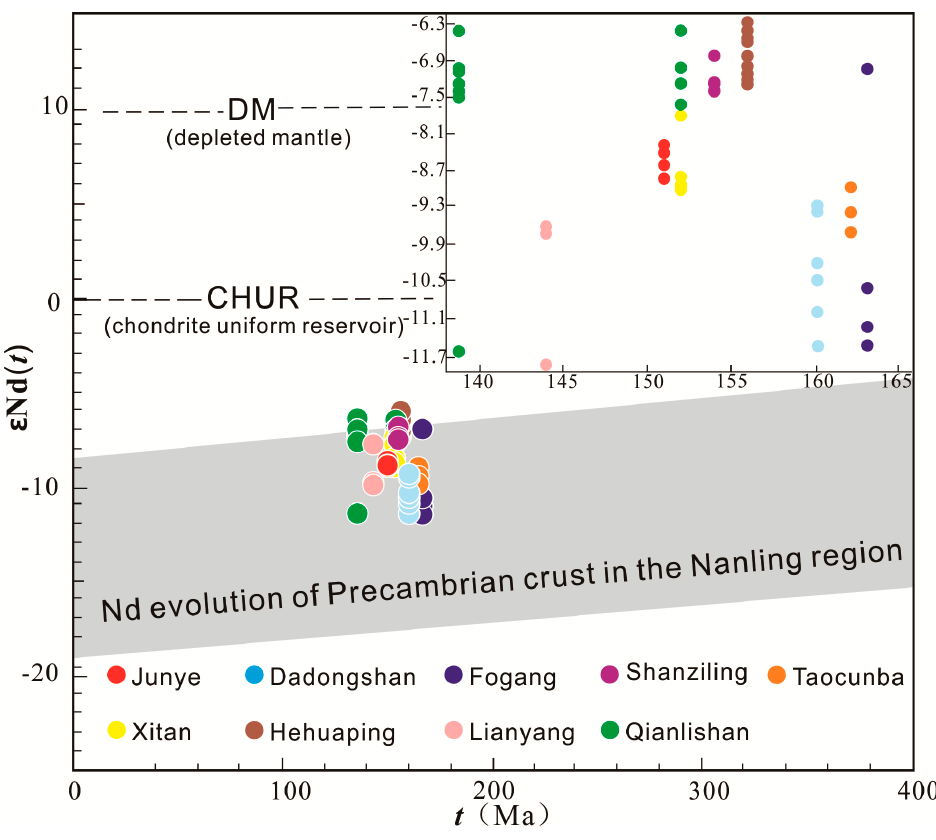
Figure 8. ε Nd(t) vs. t (Ma) diagram of granites in the Nanling region, modified after Sun et al. [82], showing the ages and ε Nd(t) values of granite plutons for Junye (this paper), Qianlishan [19], Fogang [26], Dadongshan [23], Xitian [16], Lianyang [83], Taocunba [27], Hehuaping [84] and Shaziling [80].